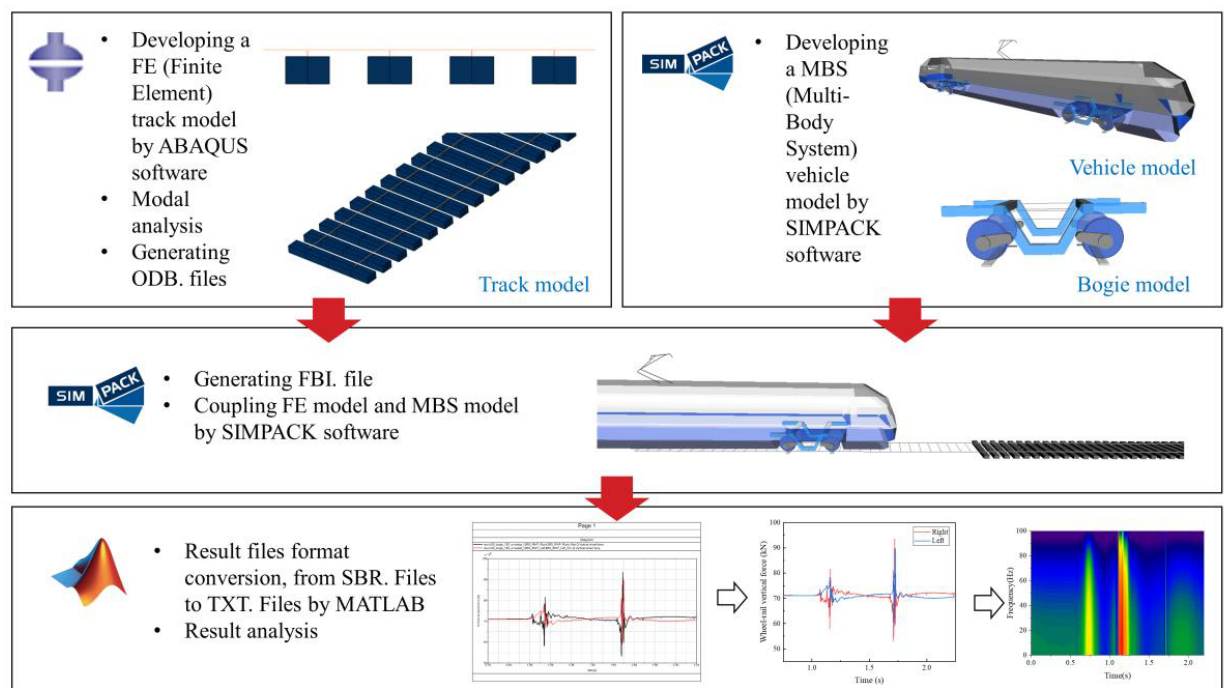
Figure 6. Coupling of vehicle and track models.